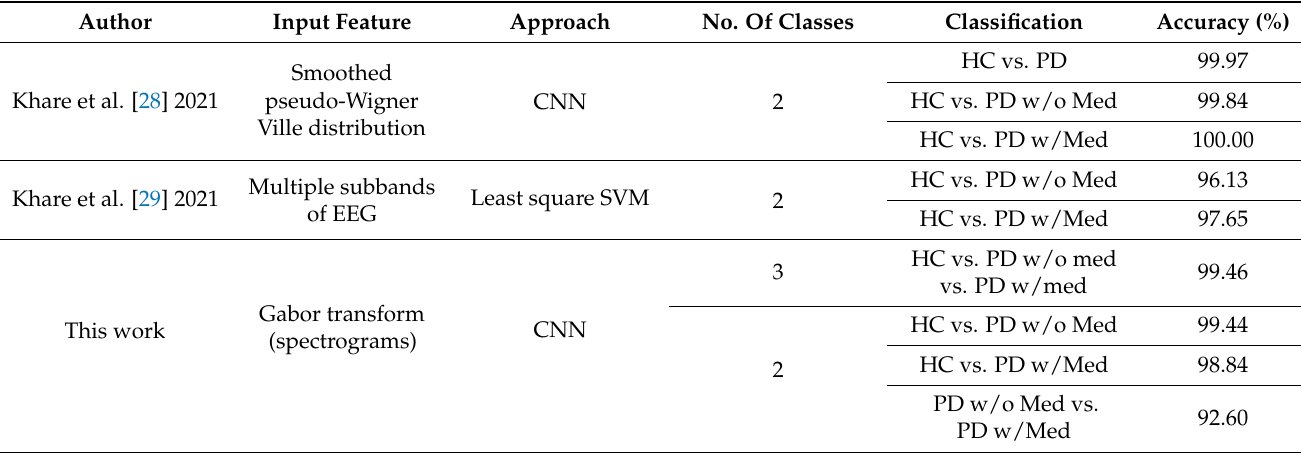
Table 7. Summary of automated PD detection studies that used the same publicly available PD dataset from OpenNeuro